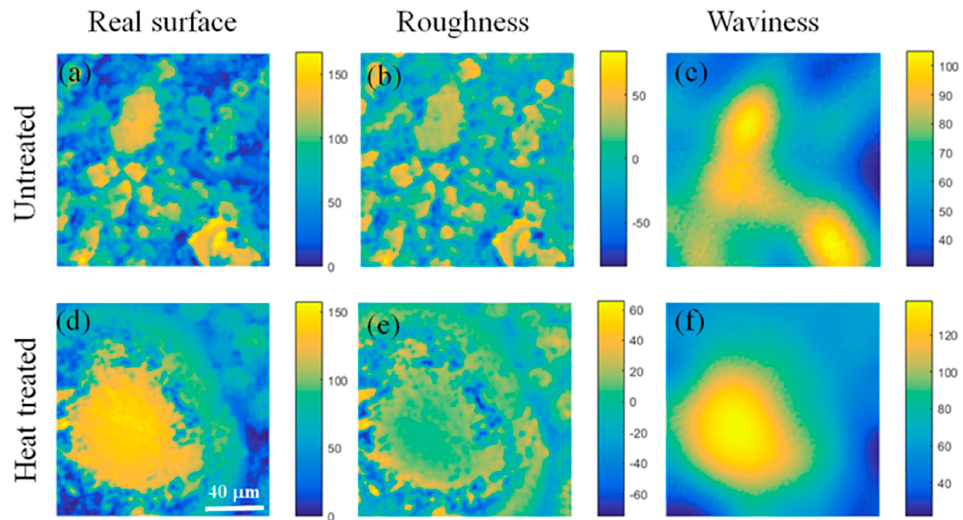
Figure 3. 3D surface topographies of Ti64 specimens measured using a laser confocal 3D profiler. (a– e )/( g – k ) Surface heights of untreated/heat-treated Ti64 specimens; ( f , l ) untreated and heat- treated Ti64 specimens, where five interrogation areas equally spaced on each Ti64 specimen were selected for surface height measurements.